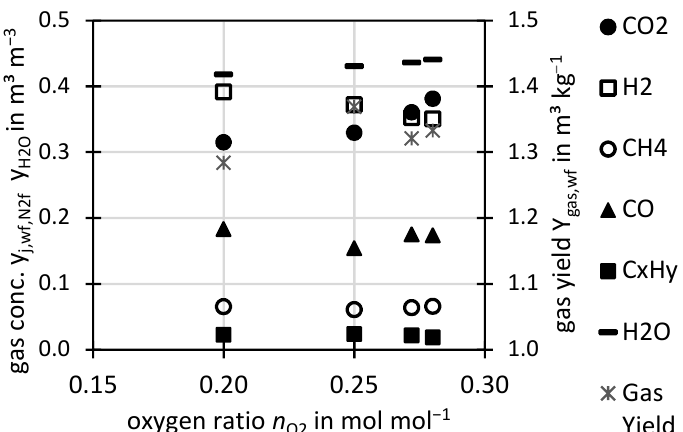
Figure 2. Permanent gas concentrations in dry N 2 -free basis, for H 2 O wet N 2 -free basis and dry N 2 - 333 free gas yield per dry ash free fuel at different oxygen ratios n O2 and constant ϑ 334